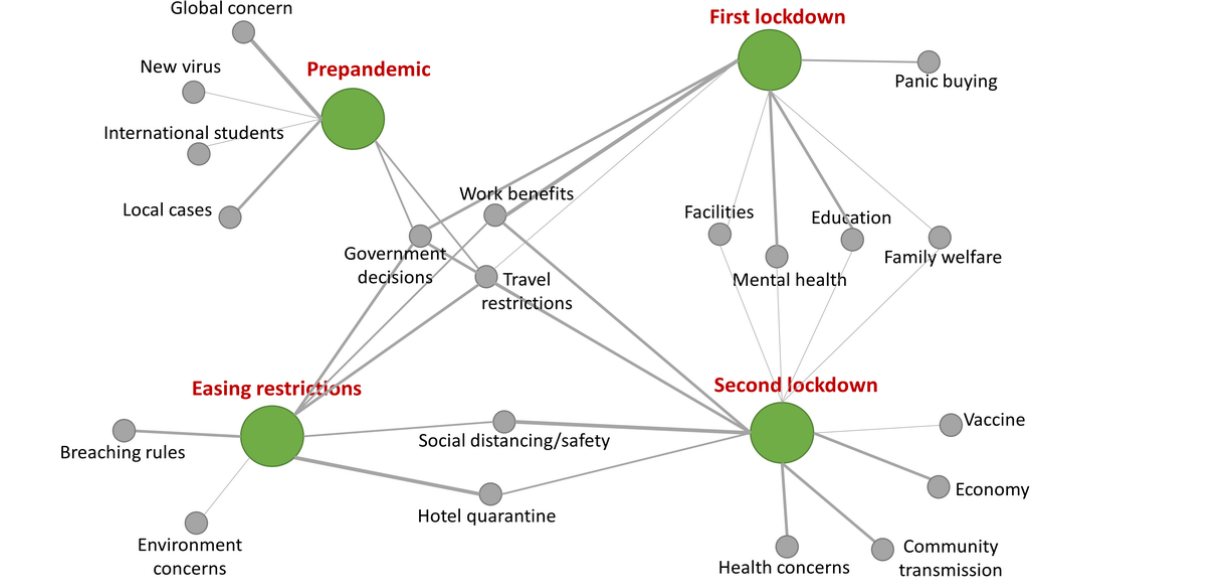
Figure 2. Topic associations between the four stages of the